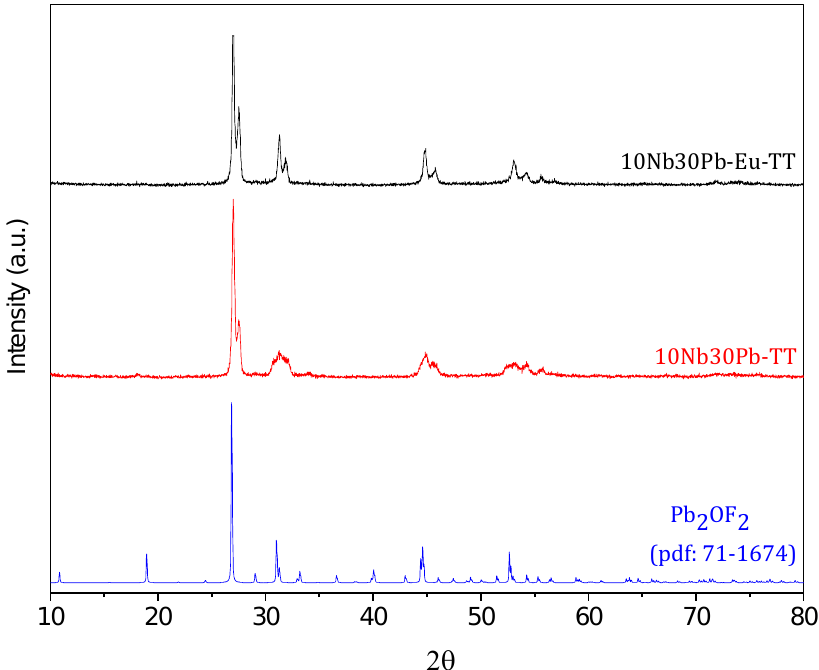
Figure 8. X-ray diffraction patterns of samples 10Nb30Pb-TT, 10Nb30Pb-Eu-TT, and crystalline reference Pb 2 OF 2 .